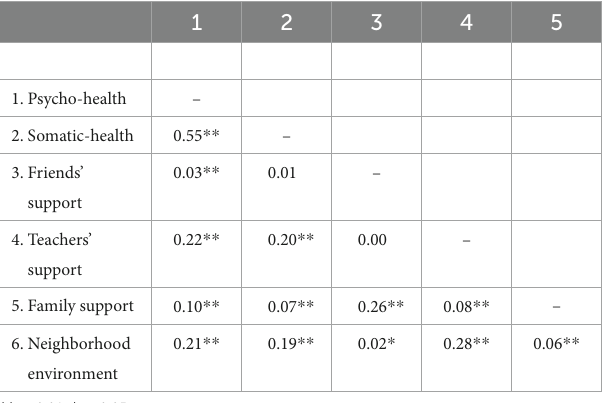
TABLE 2 Correlations between social support, neighborhood environment, and adolescents’ psychosomatic health based on the average score of each